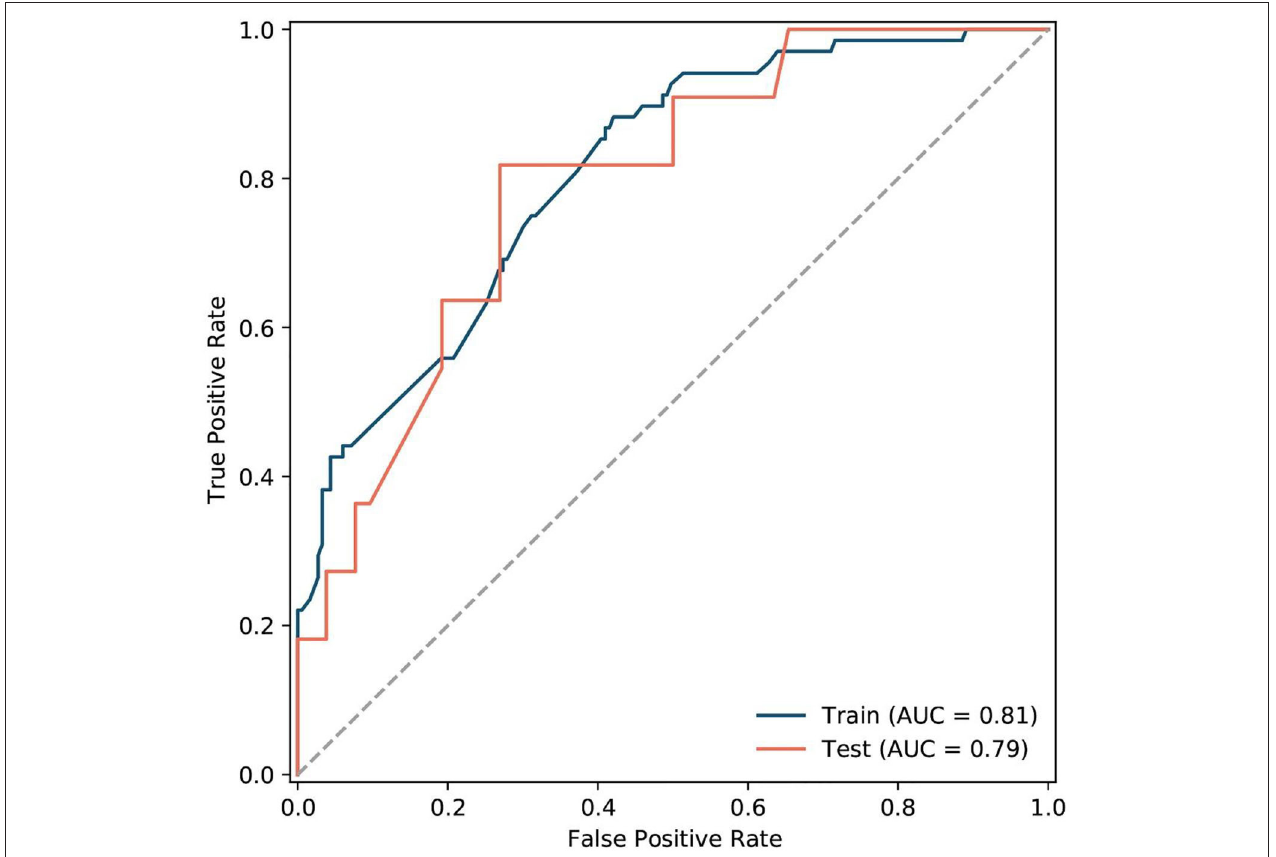
FIGURE 7 | The ROC of the radiomics signatures model for predicting AF recurrence in the training and validation